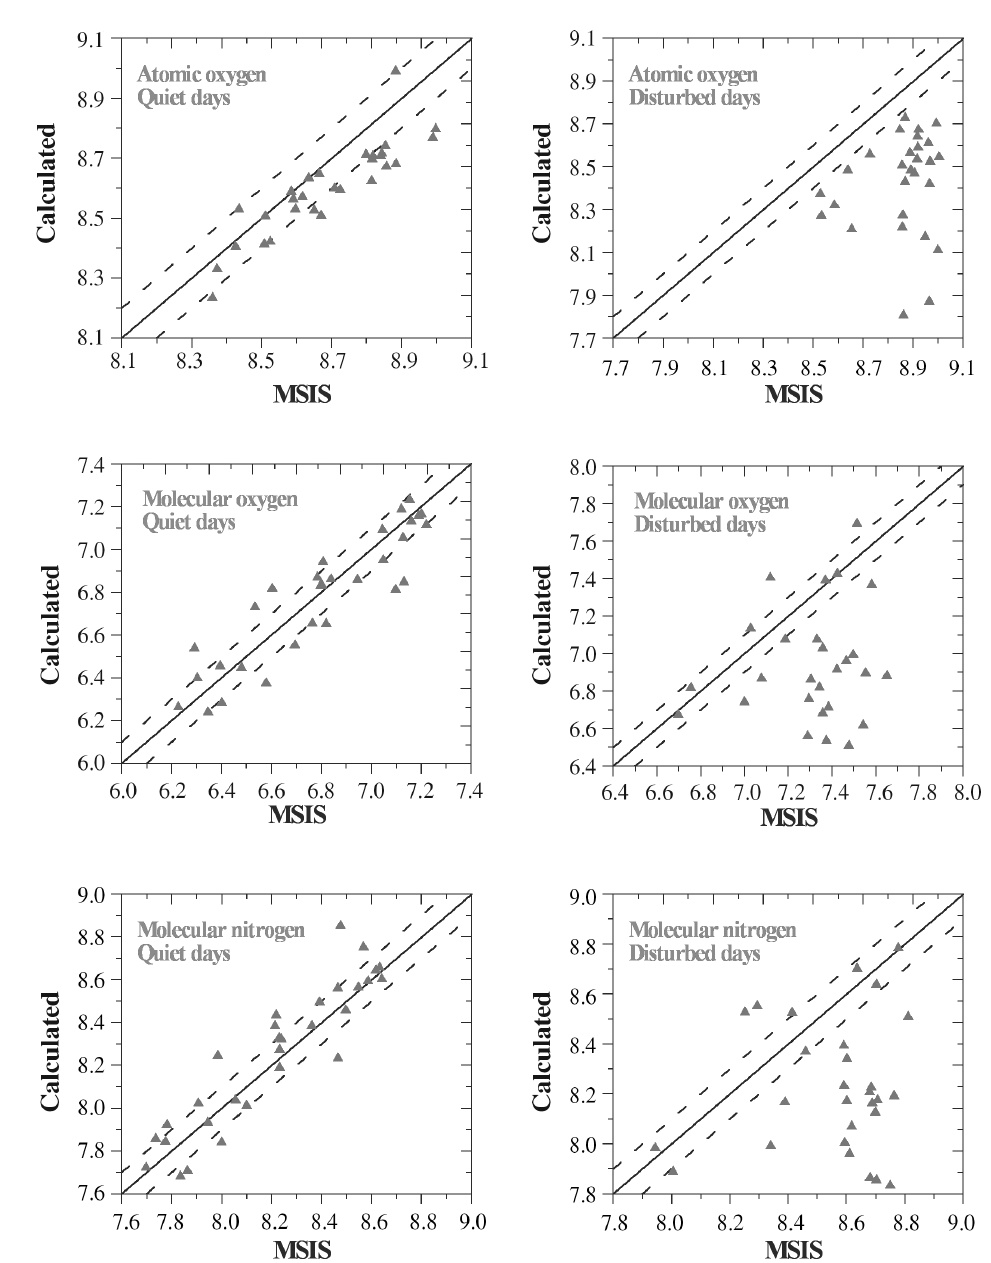
Fig. 4.6. A comparison of calculated versus MSIS-86 [O], [O 2 ], and [N 2 ] at 300 km concentrations given in log scale for quiet (left-hand panels) and disturbed (right-hand panels) days. Dashed lines indicate a ± 25% band around the